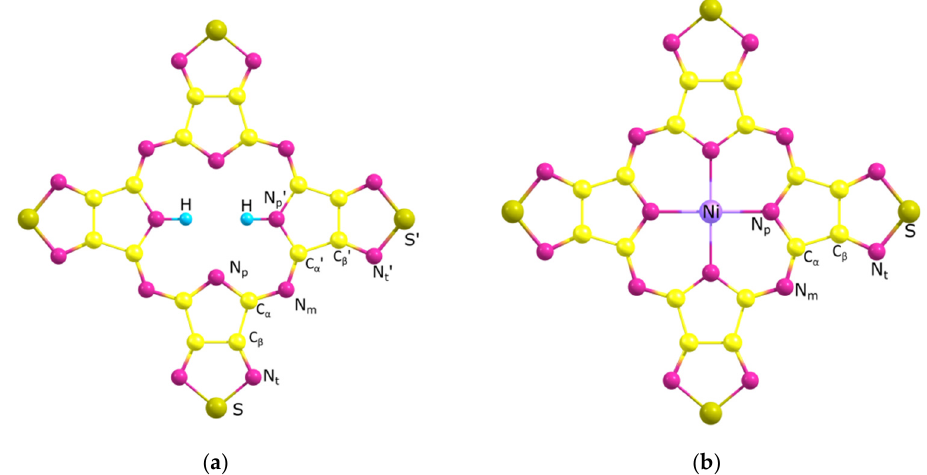
Figure 5. Models of H 2 TTDPz ( a ) and NiTTDPz ( b ) molecules with atom labeling. Table 3. Internuclear distances (r, in Å) and valence angles ( ∠ , in deg.) of H 2 TTDPz and NiTTDPz.